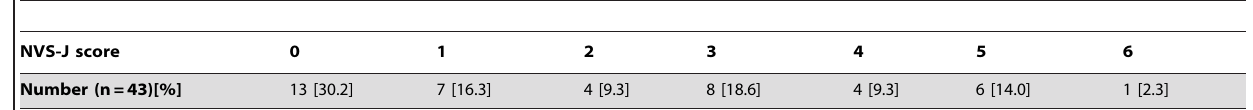
Table 2. Distribution of total NVS-J scores.